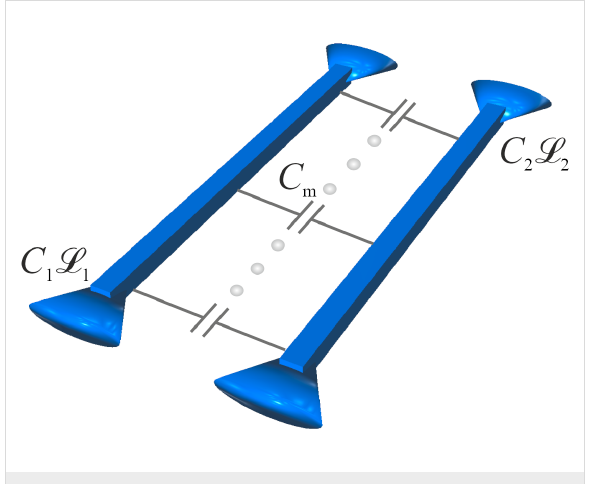
Figure 1: The system of two capacitively coupled superconducting